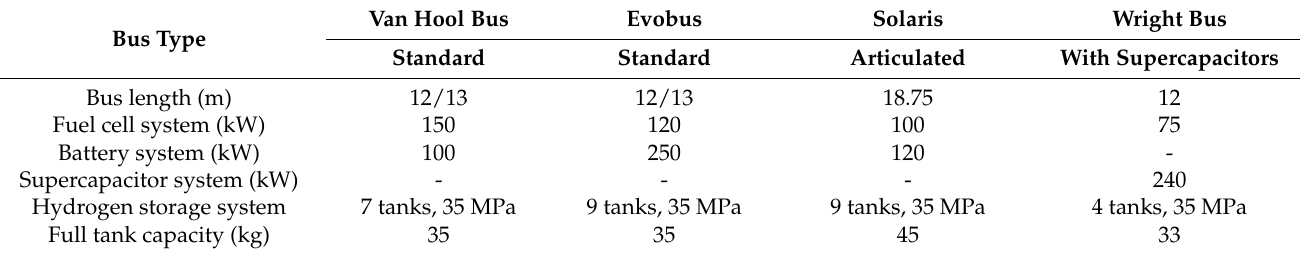
Table 2. Overview of major characteristics of FC buses currently used in European cities [30].